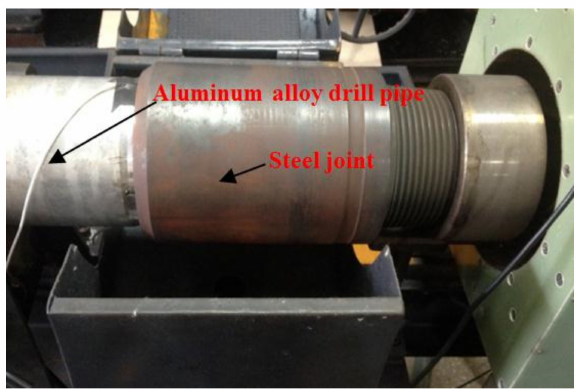
Figure 4. The hot assembly experiment.